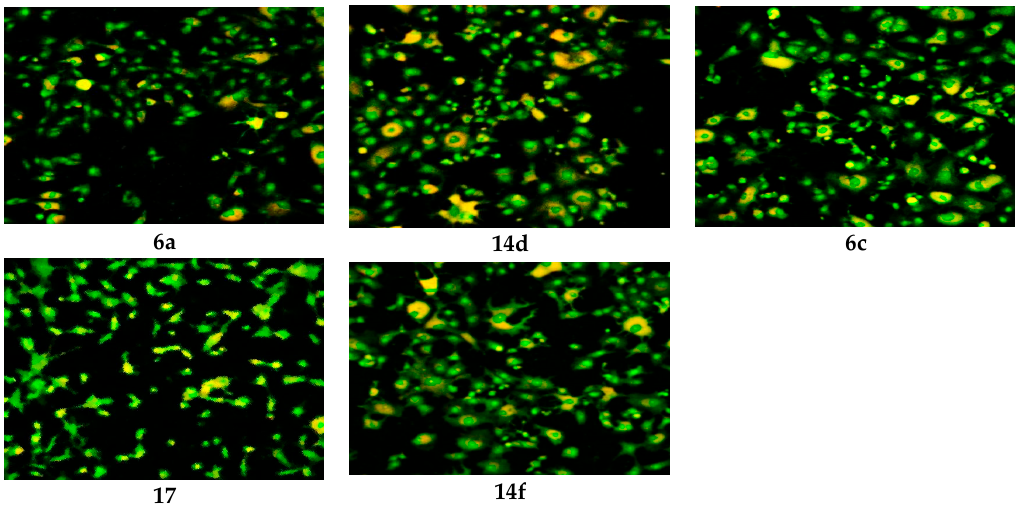
Figure 4. CLSM image of HEP G2 cell line treated with 0.6 μ M tested compounds ( 6a , 6c , 17 , 14d and 14f ). Stained by Acridine orange (green) and Rodamine 123 (Orange).